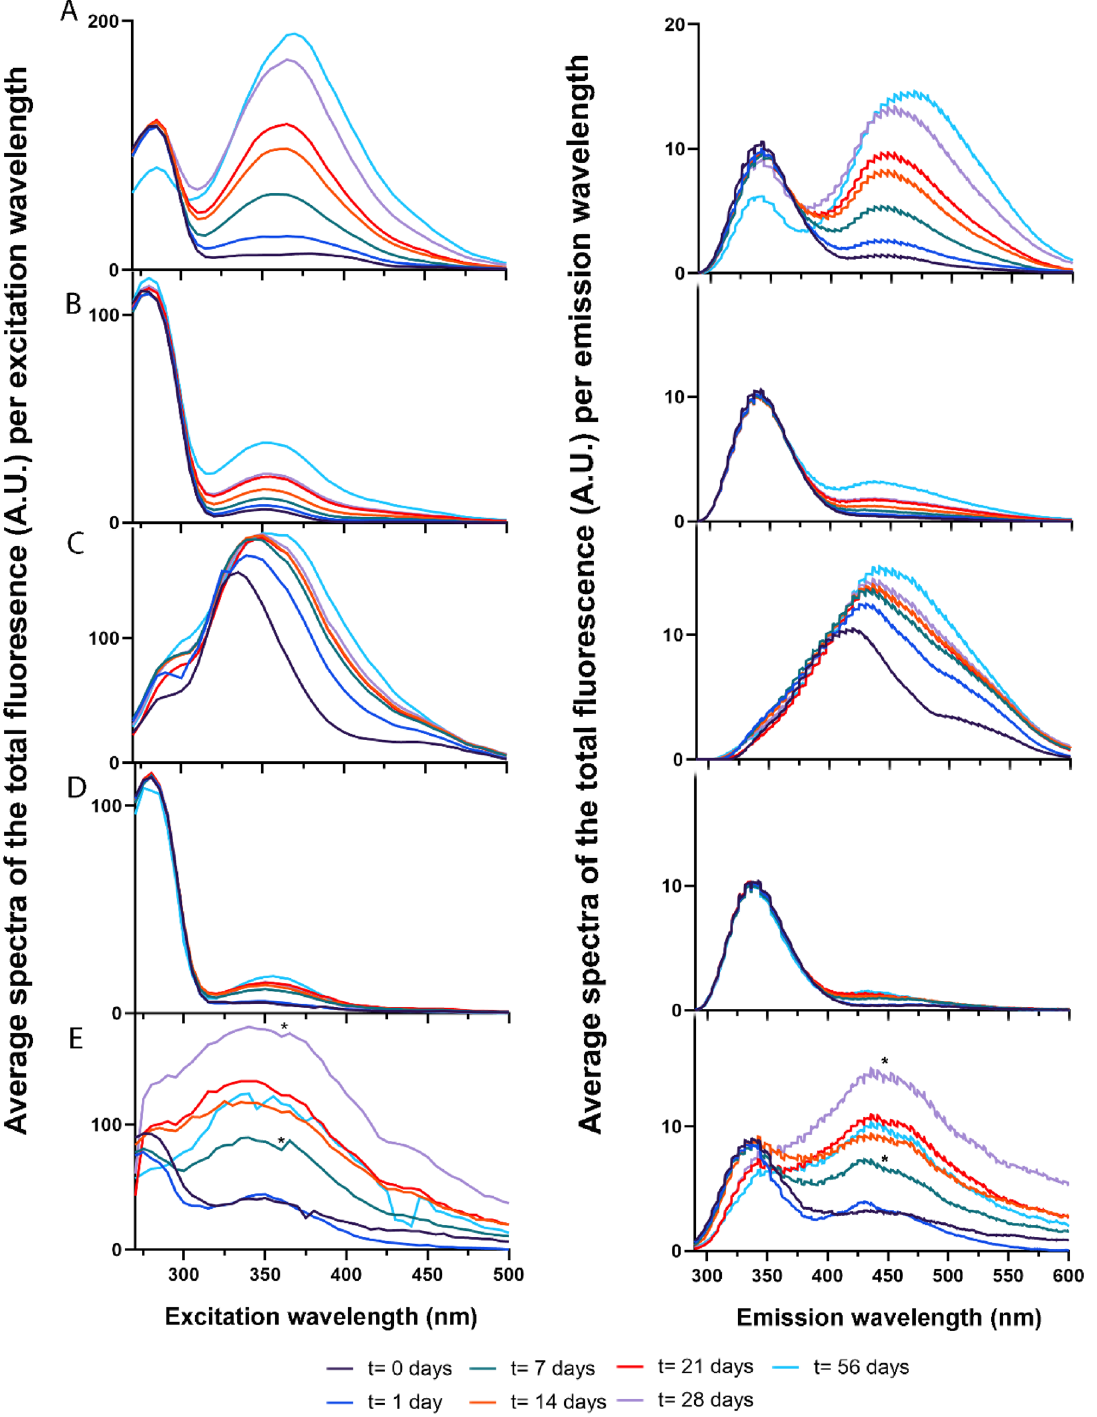
Figure 3. Fluorescent spectral signatures of different biological traces. The average of the sum of fluorescence per excitation (left) and emission (right) wavelengths (n = 7) for each time point for each body fluid, including semen ( A ), serum ( B ), urine ( C ), saliva ( D ) and fingermarks ( E ). Note, that the fingermarks that were 7 and 28 days old (indicated with *) were corrected with background measurements of day 1 and 21,